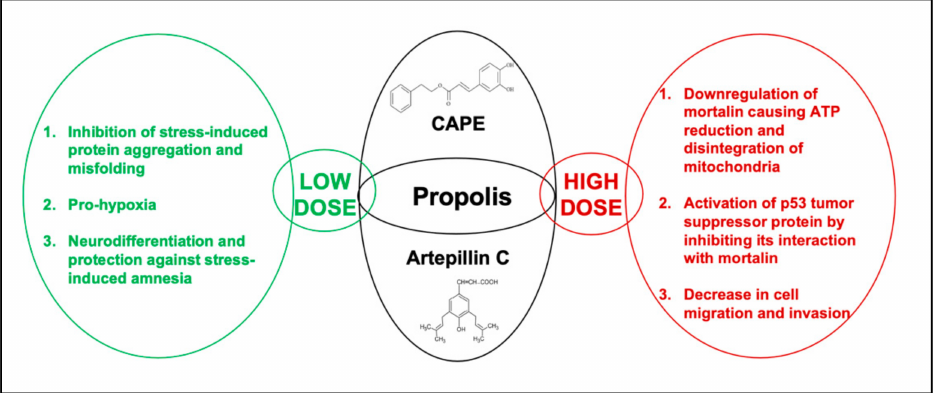
Figure 1. Schematic diagram showing the effect of low and high doses of propolis extract (CAPE and artepillin C, in particular) on cell proliferation, stress-induced protein aggregation and protein misfolding. Brazilian propolis has been shown to activate the immune system and possess direct antitumor activity [171]. Artepillin C (ARC) was shown to exhibit a cytotoxic effect and inhibit the growth of human and murine malignant tumor cells in vitro and in vivo. It was also found to cause significant damage to solid tumors and leukemic cells [83,101]. Apop- tosis, abortive mitosis and massive necrosis were identified by histological